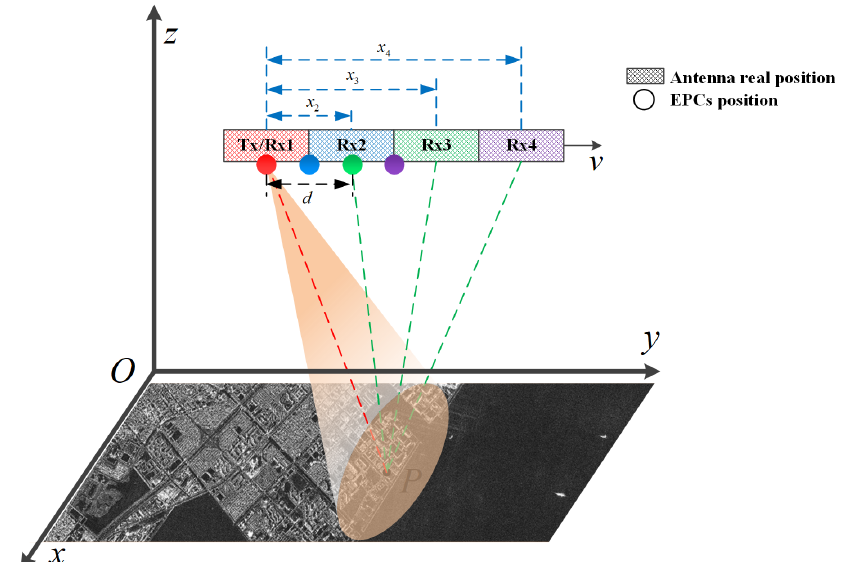
Figure 1. The observation geometry of the multichannel SAR system with four channels.